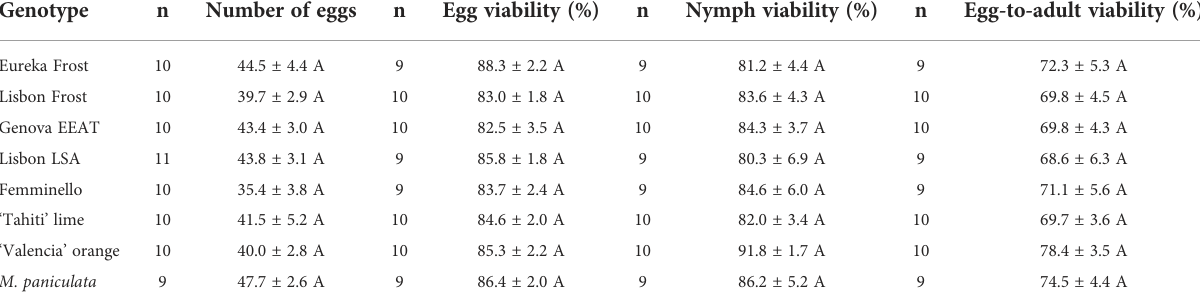
TABLE 7 Parameters of the life cycle of Diaphorina citri on different lemon varieties, ‘ Tahiti ’ lime, ‘ Valencia ’ orange and Murraya paniculata . Genotype n Number of eggs